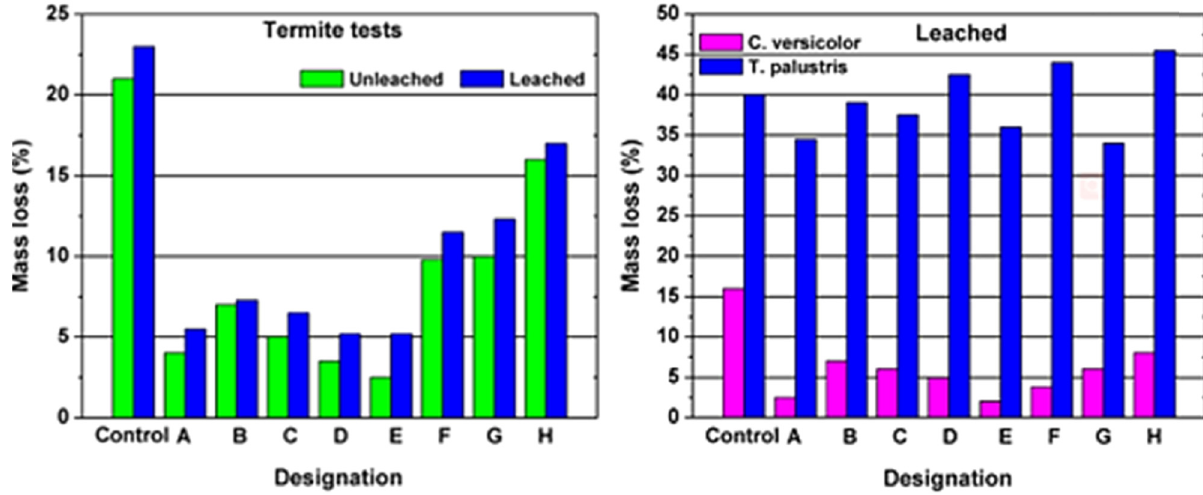
Figure 16: The mass loss ( % ) following termite resistance for leached and unleached pine wood: ( a ) nano - zinc oxide; ( b ) nano - zinc oxide plus binder A; ( c ) nano - zinc oxide plus binder B; ( d ) nano - zinc borate; ( e ) nano - zinc borate plus binder A; ( f ) nano - copper oxide; ( g ) nano - copper oxide plus binder A; and ( h ) nano - copper oxide plus binder B [ 134 ]